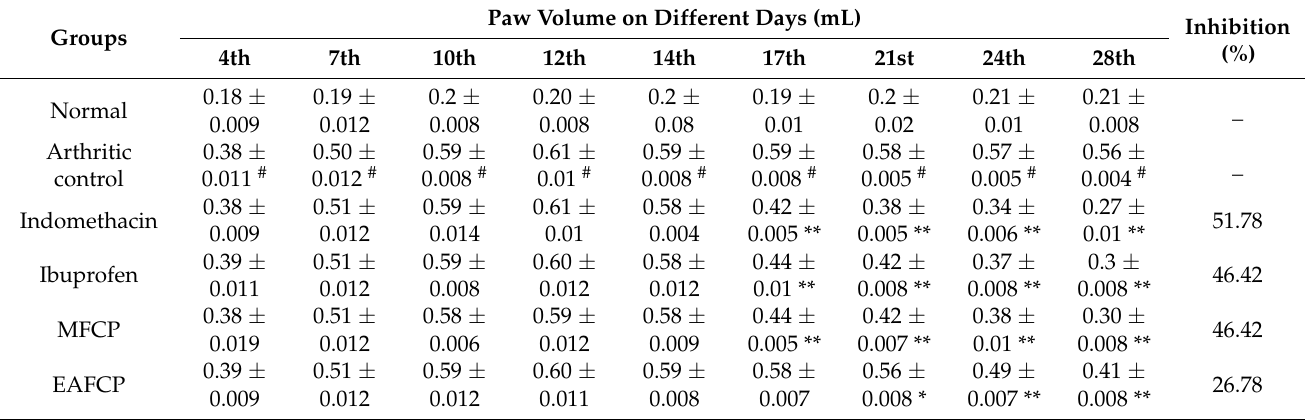
Values are mean ± SEM for 6 animals. * p < 0.05, ** p < 0.01 vs. control group # p < 0.01 when compared to normal control. One-way ANOVA followed by Dunnett test were used. Methanol fraction of Swallow wort (MFCP) showed similar percentages inhibition with that of